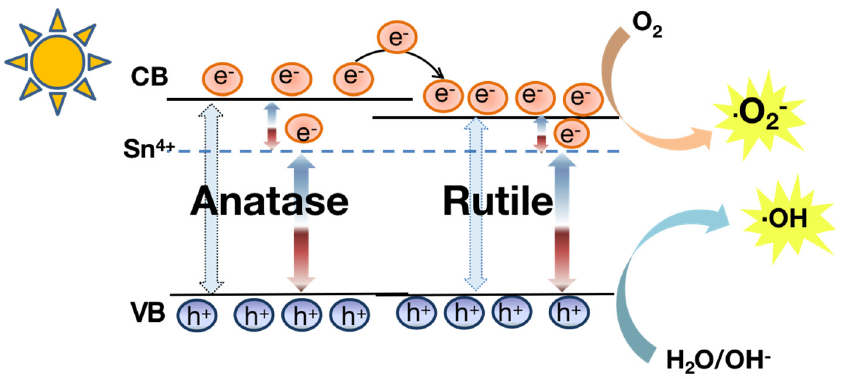
Figure 8. Schematic diagram of transfer path of the photogenerated charges in Sn–TiO 2 .